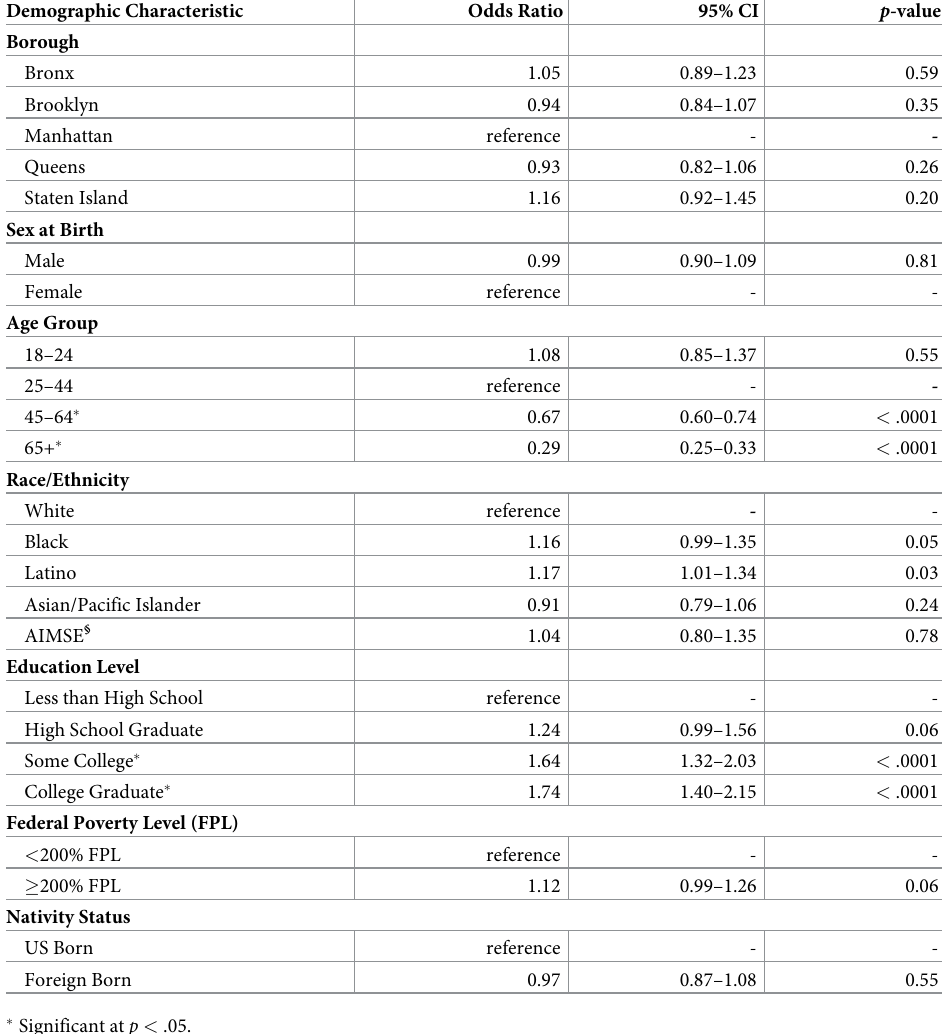
Table 3. Odds of providing a text contact at the time of Healthy NYC enrollment (n = 8,367) �� . Demographic